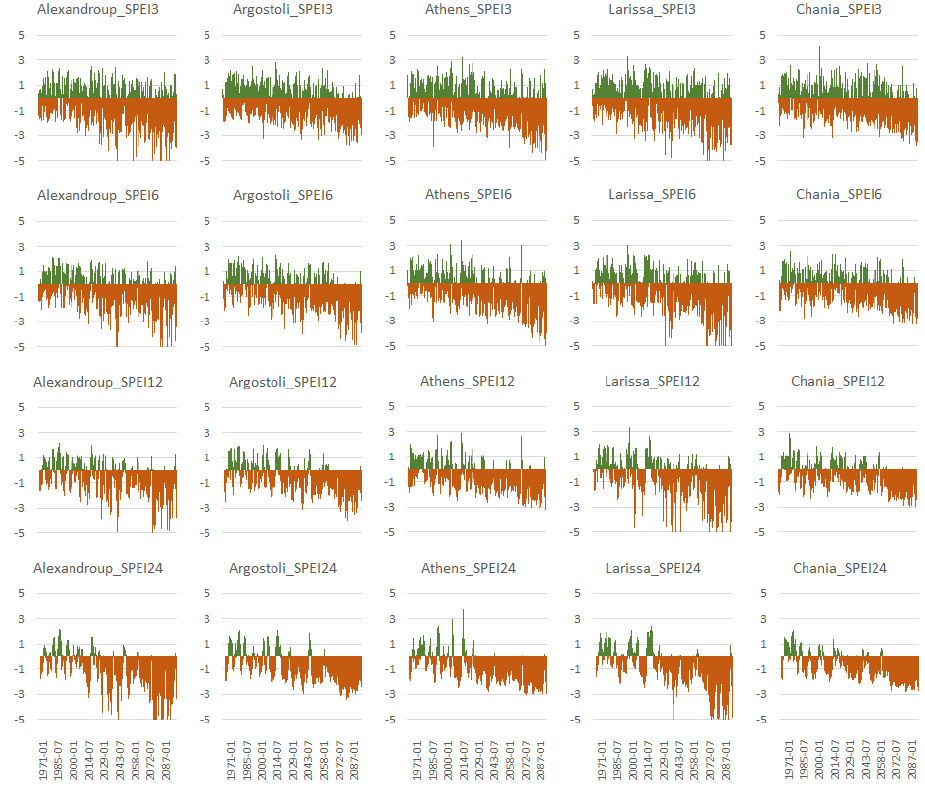
Figure 15. Similar to Figure 14, but for the standardized precipitation evapotranspiration index (SPEI).